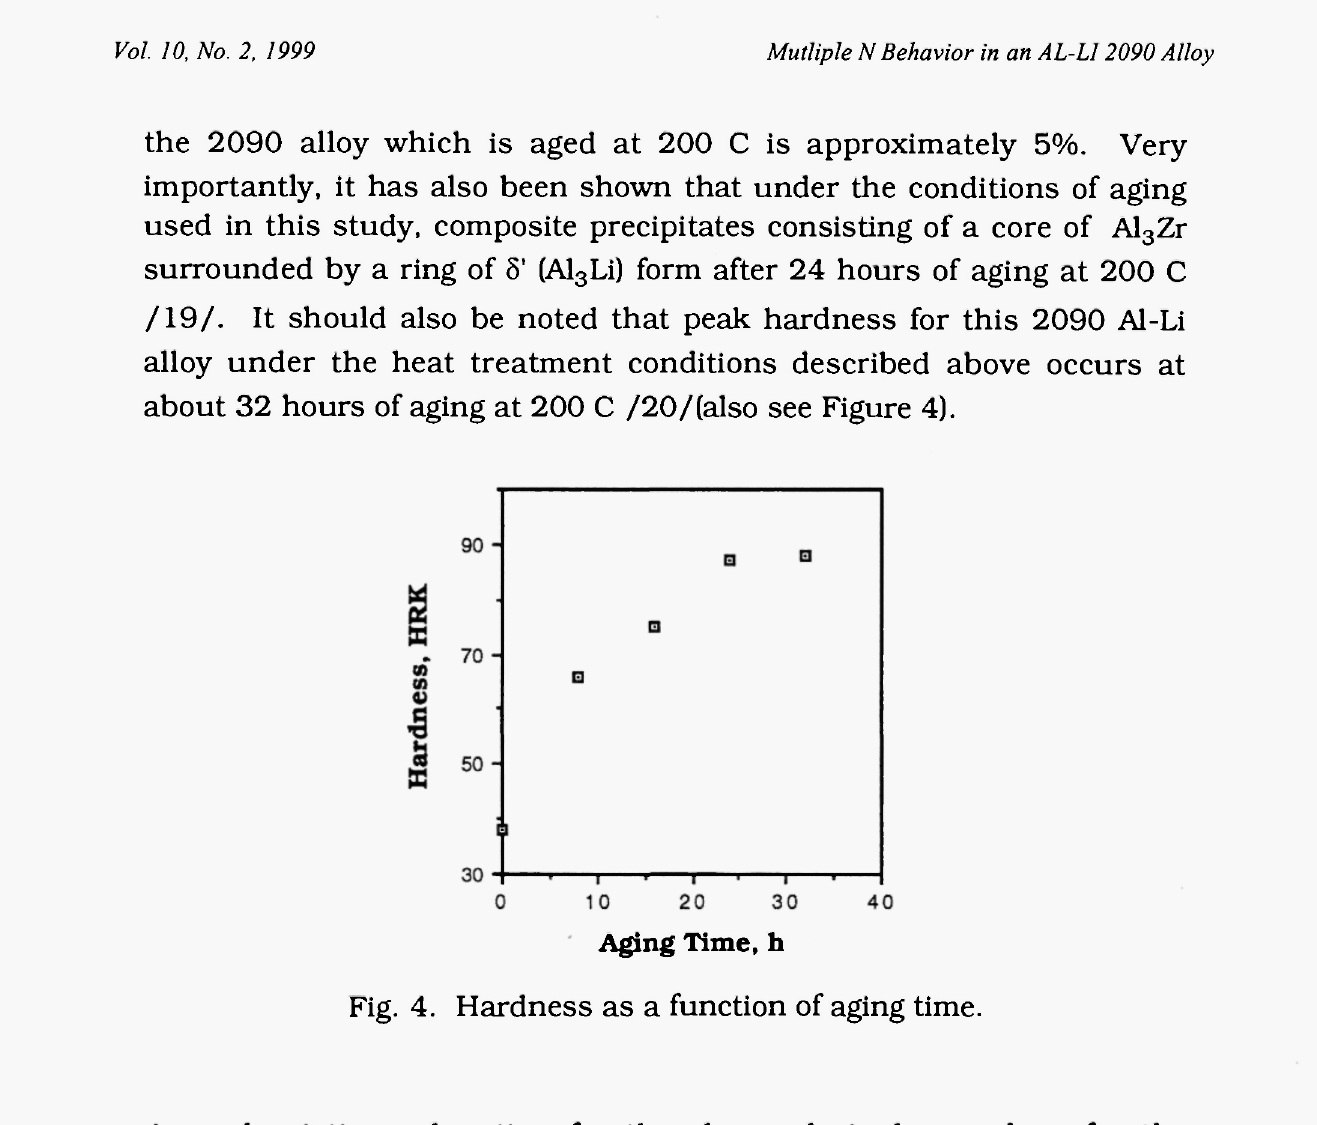
Fig. 4. Hardness as a function of aging